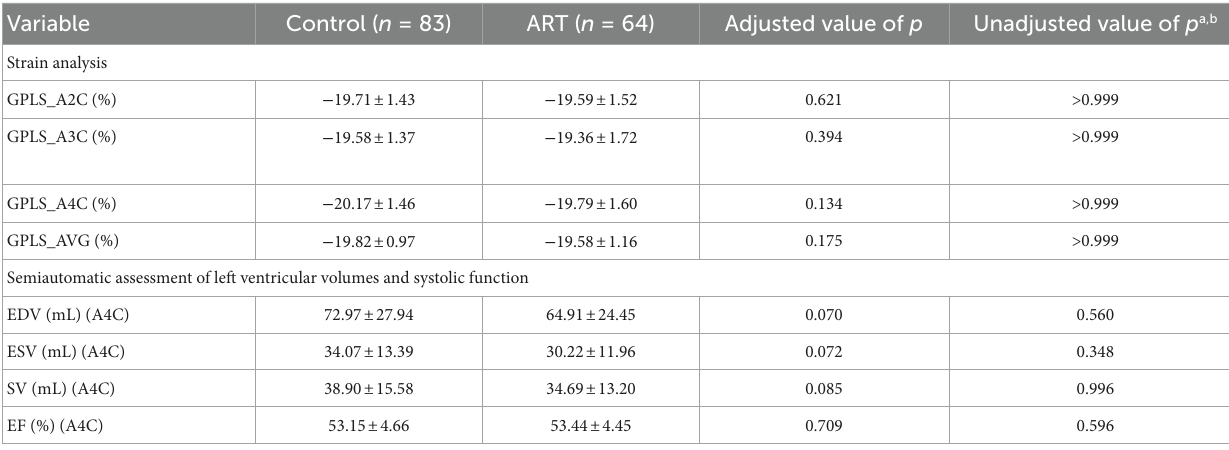
TABLE 4 Two-dimensional speckle tracking